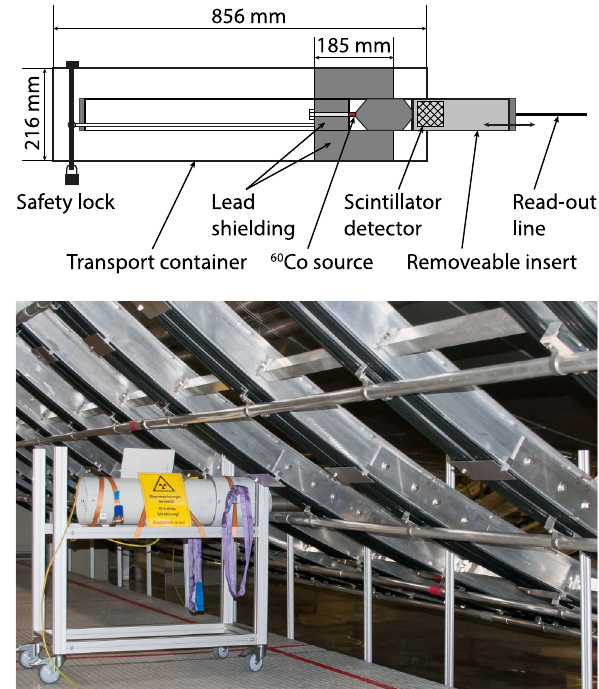
Fig. 5 The 60 Co source used to increase the gamma radiation at the MS. The upper panel is a schematic of the source (in the “closed” configuration). In the bottom panel, the source can be seen